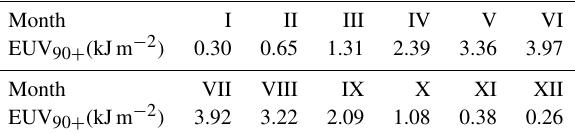
Table 3. Threshold values of EUV radiation daily doses for days with EUV 90 + in individual